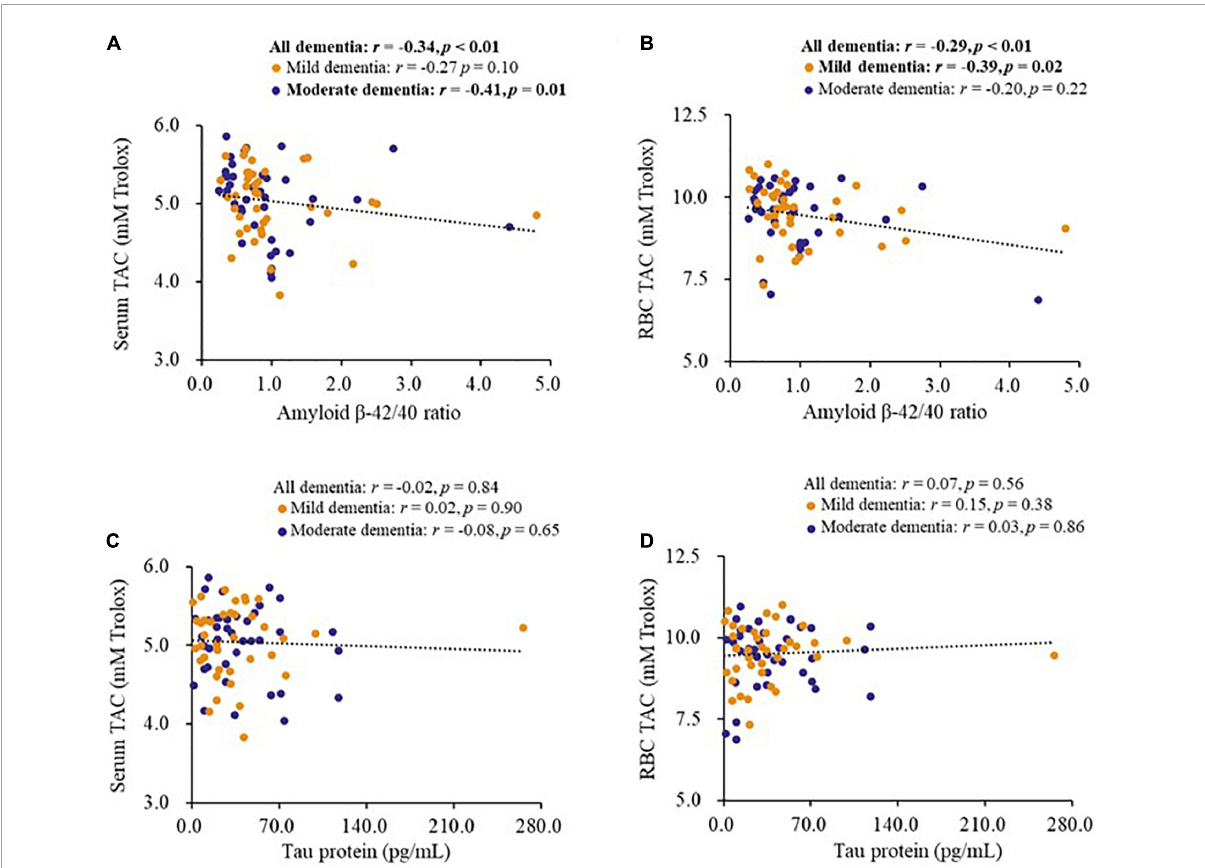
FIGURE1 Correlations between biomarkers for dementia and antioxidant capacity of patients. (A,B) Correlations between the level of amyloid β -42/40 ratio and antioxidant capacity. (C,D) Correlations between the level of tau protein and antioxidant capacity. CoQ10, A β , Tau in Dementia.